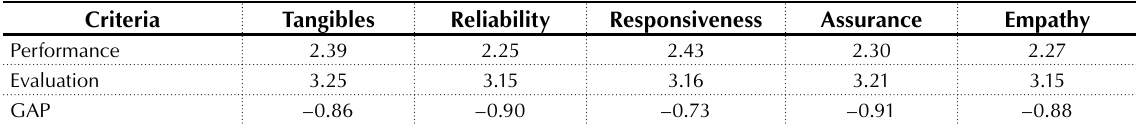
Table 5. Gap score of SERVQUAL dimensions